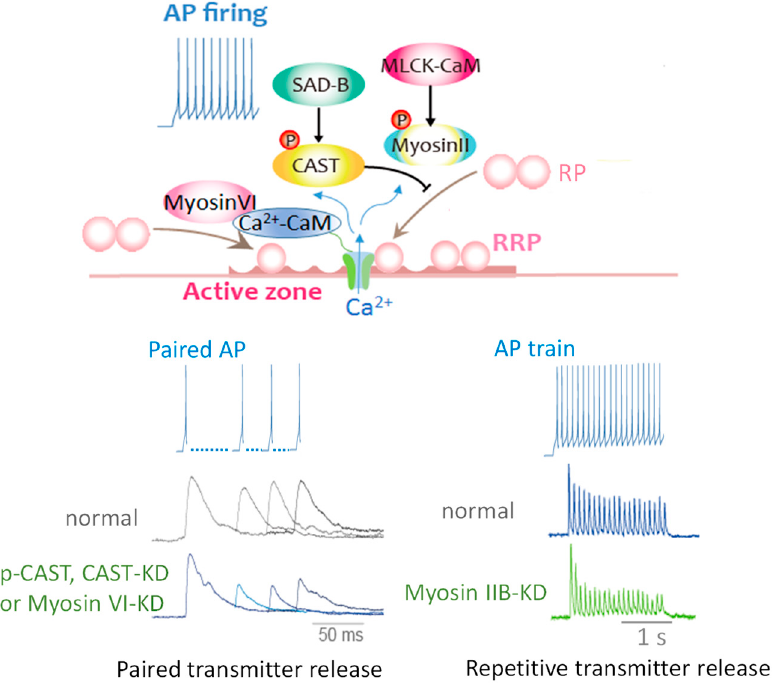
Figure 7. Milliseconds Ca 2+ dynamics activates multiple proteins for controlling release ‐ ready SVs. Myosin IIB and VI activated by Ca 2+ /CaM dependent on APs firing pattern translocate SVs to re ‐ store release ‐ ready state SVs. In contrast, APs ‐ induced CAST phosphorylation brakes release ‐